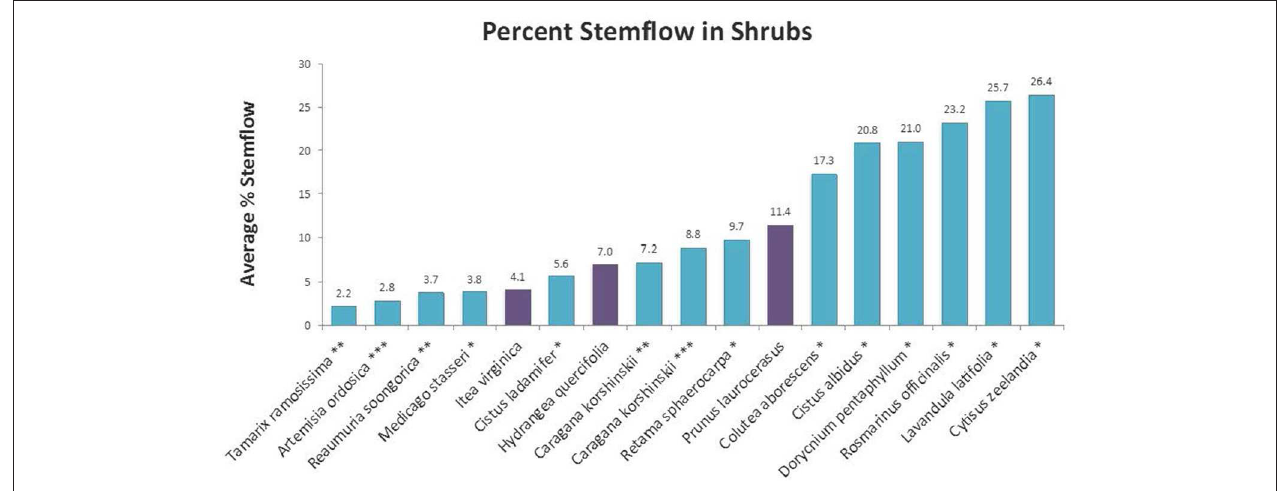
FIGURE 5 | Determined percent stemflow compared to other species (Sources: *Garcia-Estringana et al., 2010; **Li et al., 2008; ***Zhang et al.,